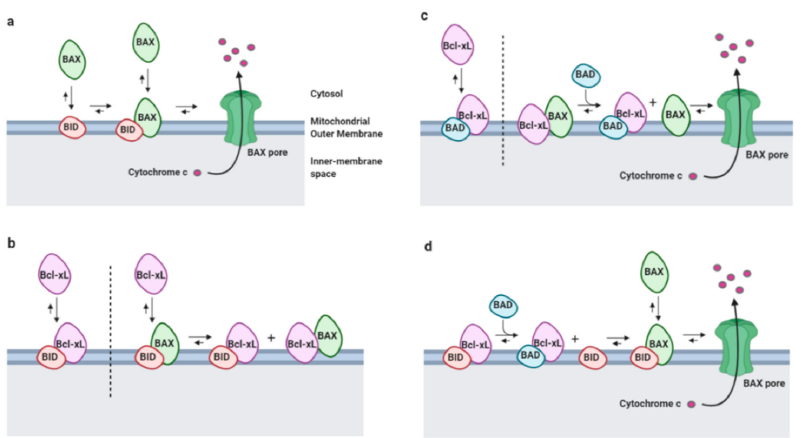
Figure 1. The interactions between the different members of the B-cell lymphoma (Bcl-2) family control mitochondria outer membrane permeabilization (MOMP) and subsequent apoptosis. All